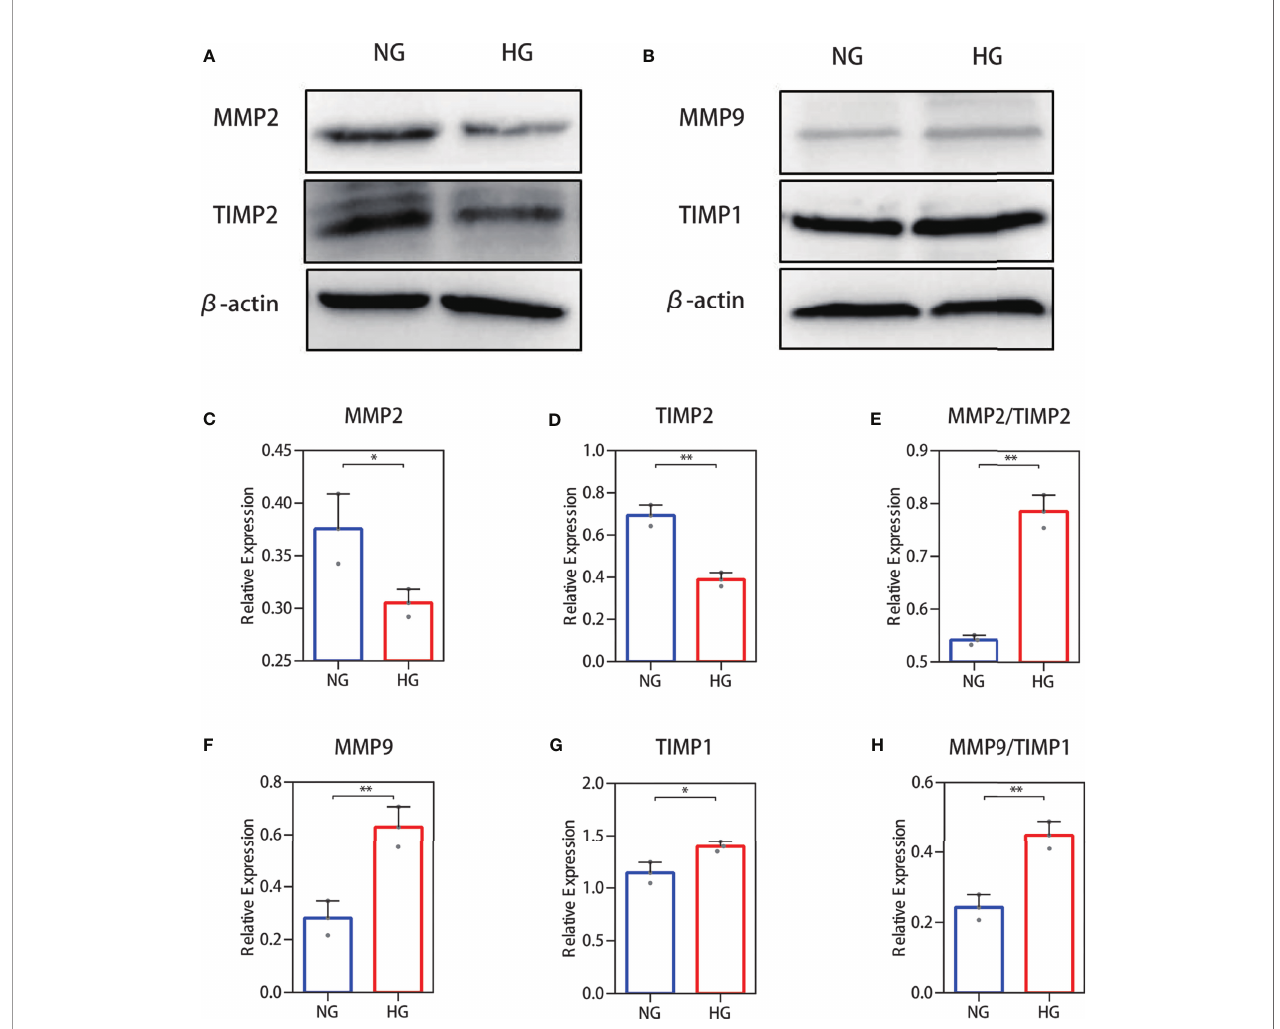
FIGURE 4 | Western blot analysis of the MMP-2/TIMP-2 and MMP-9/TIMP-1 ratio in high glucose-treated HDFs. (A, B) Representative Western blots of MMP-2 and TIMP-2 as well as MMP-9 and TIMP-1. (C, E) Semiquantitative analysis of MMP-2, TIMP-2, and the MMP-2/TIMP-2 ratio. (F – H) Semiquantitative analysis of MMP-9, TIMP-1, and the MMP-9/TIMP-1 ratio. The independent experiment was repeated three times. The results are provided as the means ± SEM, * p < 0.05, ** p < 0.01 compared with the